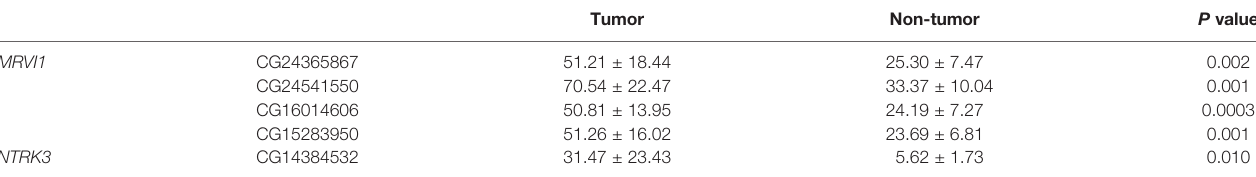
TABLE 2 | Association between MRVI1 and NTRK3 methylation status and cervical